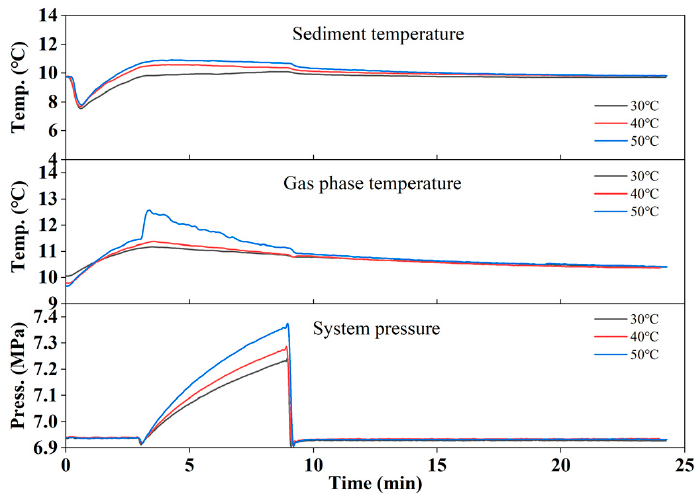
Figure 7. E ff ect of injection temperature of hot brine on gas production. Figure 7. Effect of injection temperature of hot brine on gas